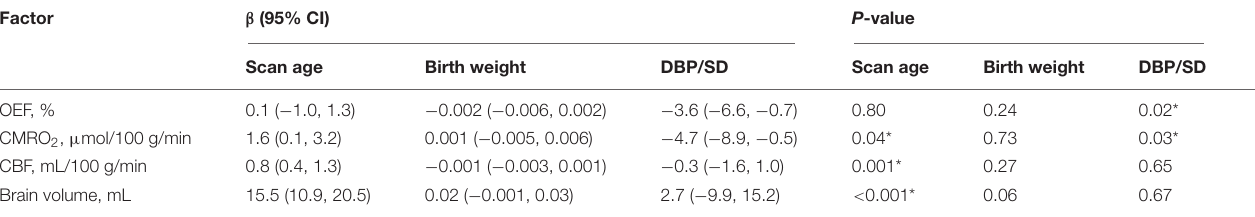
TABLE 4 | Association between maternal DBP (mmHg) and measured physiological parameters ( N = 38). Factor